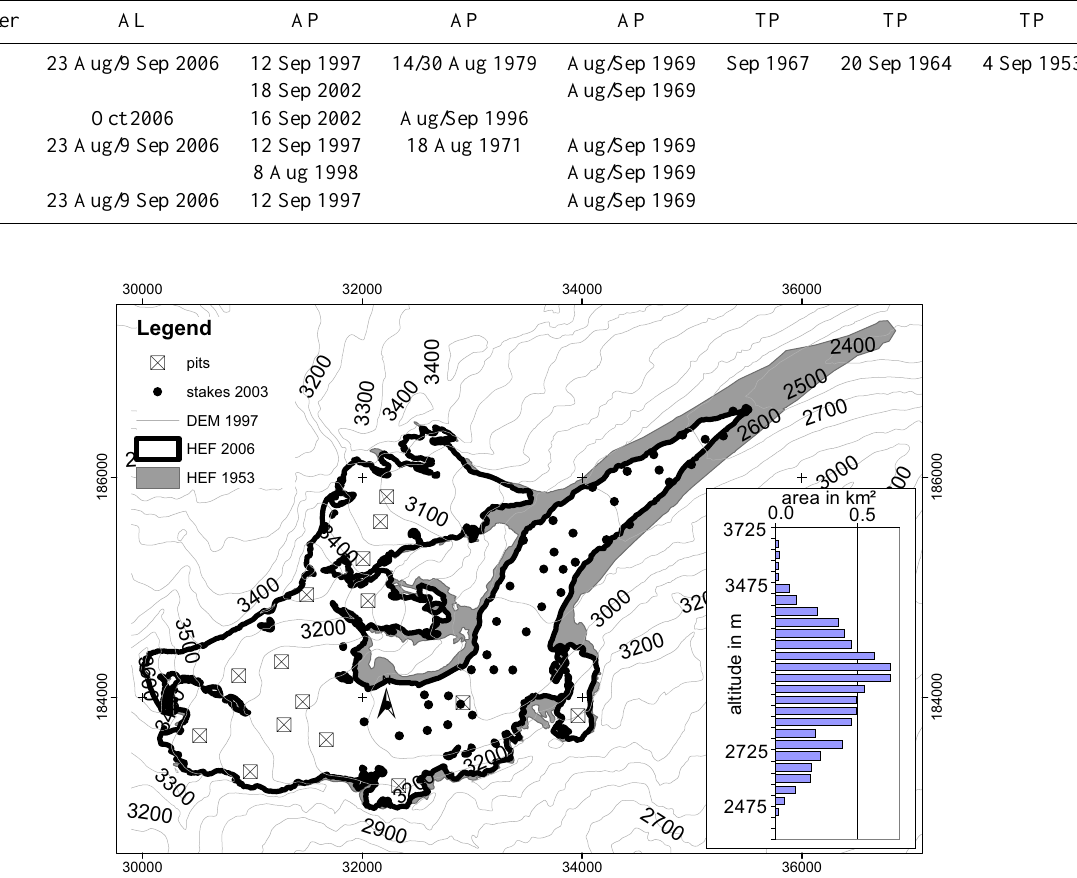
Fig. 5. Map of Hintereisferner, ¨Otztal Alps, with position of pits and stakes in